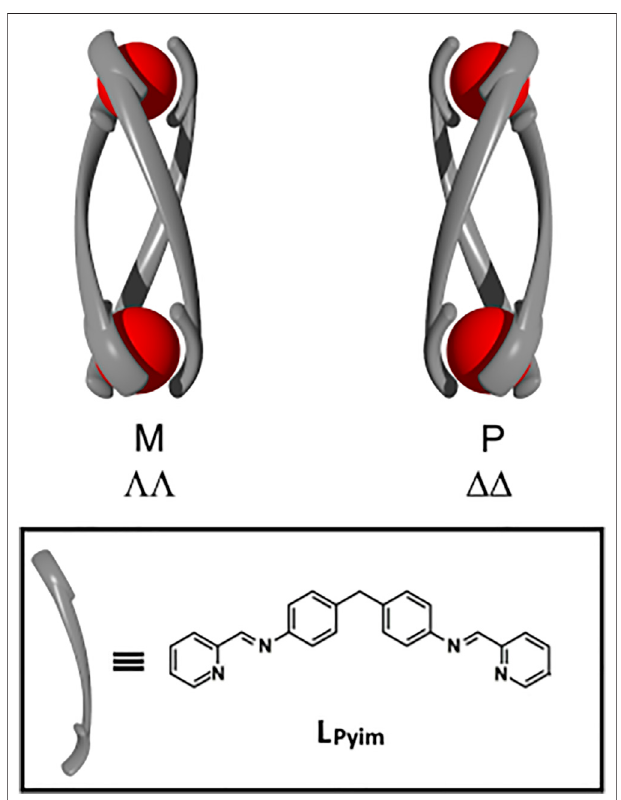
FIGURE 1 | Cartoon representations of the minus (M, ΛΛ ), plus (P, ΔΔ ) helicate isomers of a generic triple-stranded helicate and the chemical structure of the (1E,1 ′ E)-N,N ′ -[methylenebis(4,1-phenylene)]bis[1-(pyridin-2- yl)methanimine] ligand ( L Pyim ) developed by Hannon and co-workers (Hannon et al.,